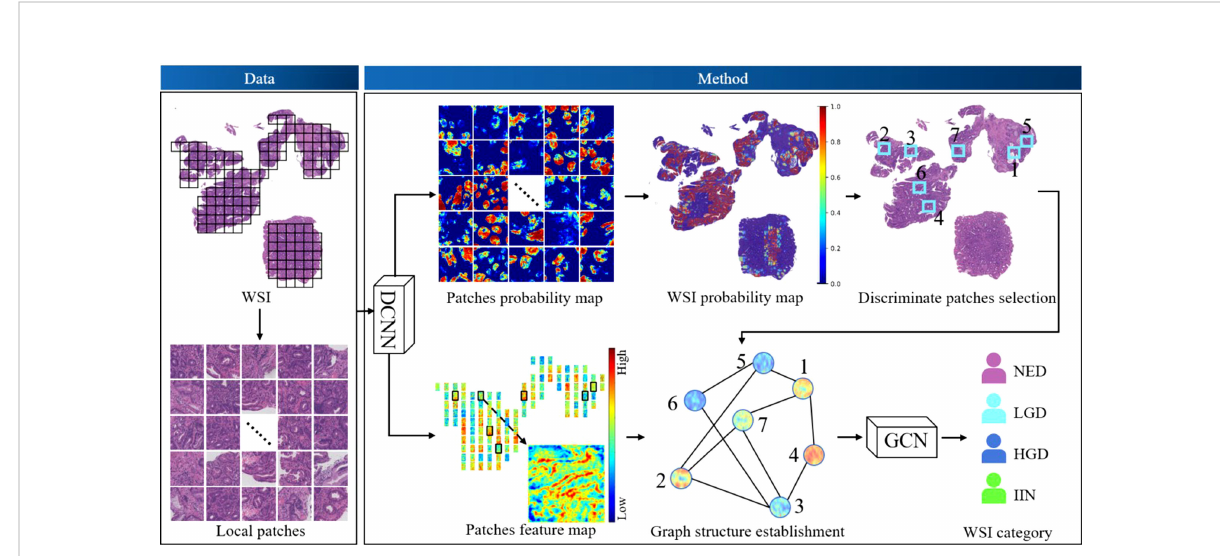
FIGURE 2 The work fl ow of the algorithm. Deep convolutional neural networks (DCNNs) and deep graph convolutional networks (GCNs) were used. DCNNs were selected to acquire the probability map of patches and extract the feature map of patches. Discriminative patches were selected with reference to the overall probability map of whole-slide images (WSIs), which was obtained by stitching all patch probability maps. Thus, the graph of WSIs was constructed based on discriminative patches and corresponding feature maps, and the graph was fed into the GCN model to obtain a fi nal classi fi cation. HGD, high-grade dysplasia; IIN, intramucosal invasive neoplasia; LGD, low-grade dysplasia; NED, negative for dysplasia.